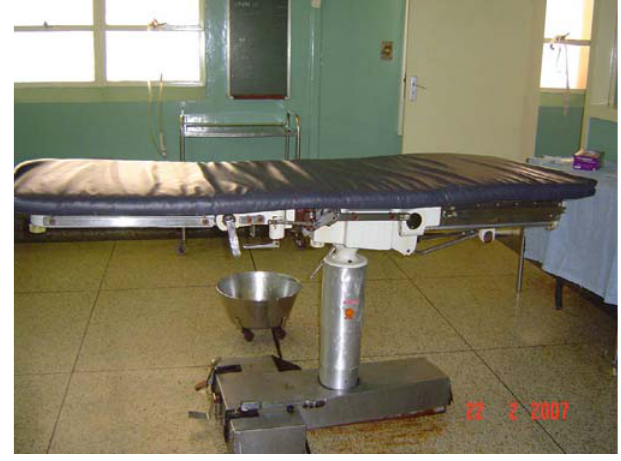
Figure 2. Basic Surgical Supplies and